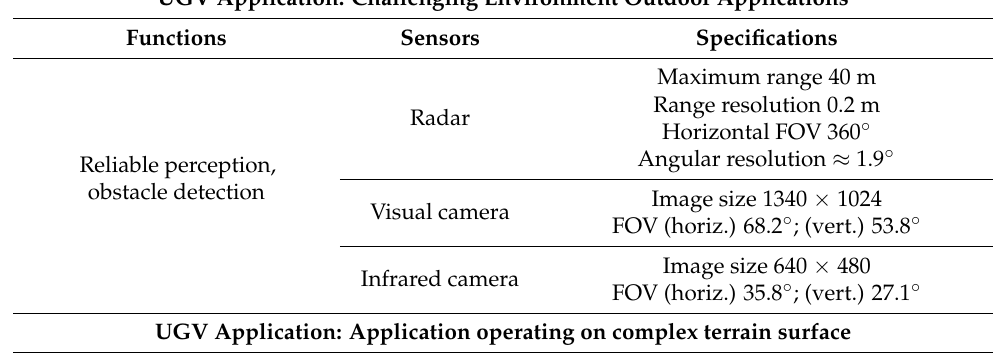
Table 4. Some examples of UGV sensor application